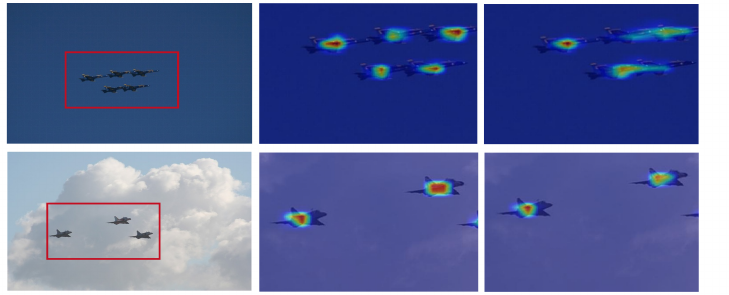
Figure 14. The comparison of the heat maps of CFM and S2AM with and without. The left image for each line represents the original sample, the middle image displays the results of a heat map using a few modules, and the right image does not.